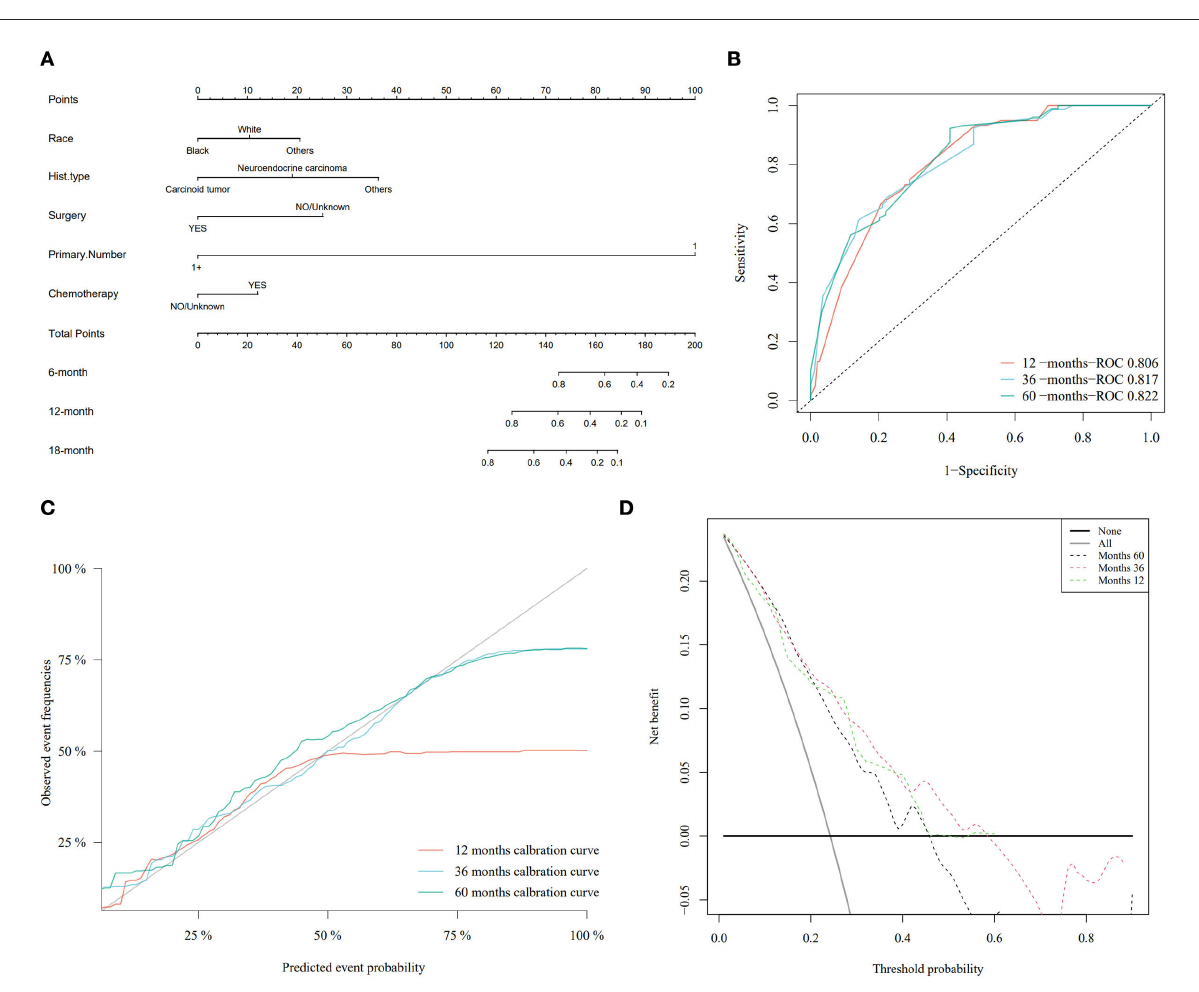
is puzzling, and perhaps more samples should be